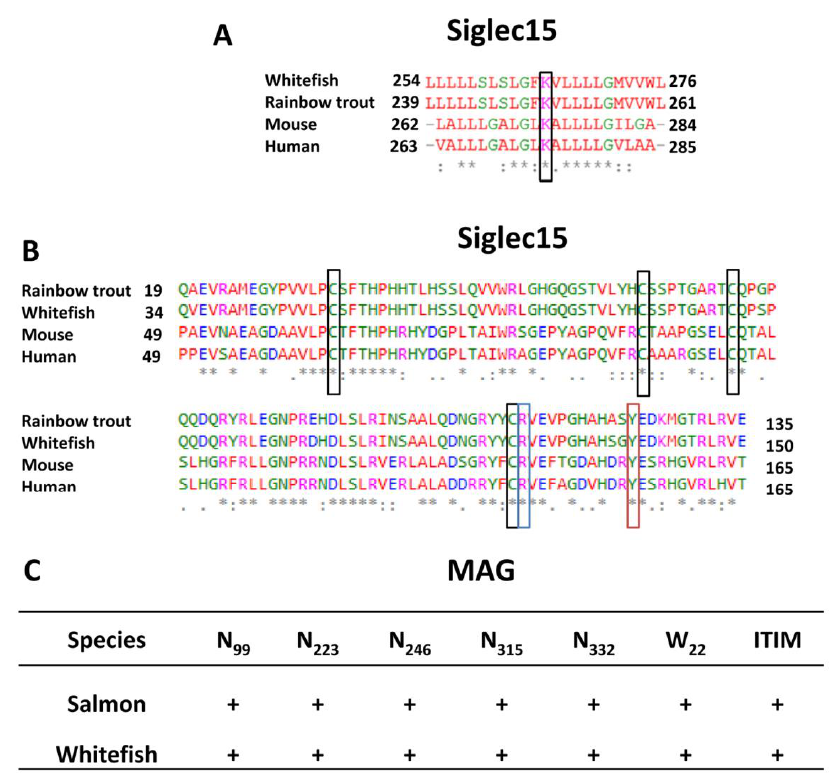
Figure 5. Analysis of specific properties of Siglec15 and MAG. ( A ) Sequence alignment of the transmembrane domain of Siglec15. The positions of the transmembrane domains of murine and human Siglec15 were retrieved from Uniprot, while the transmembrane area of Siglec15 from maraena whitefish and rainbow trout were predicted using SMART. The black box highlights the transmembrane lysine residue, which interacts with DAP10/12. ( B ) Sequence alignments of the first Ig domain of Siglec15. The alignment illustrates the conserved cysteine residues (black boxes) of Siglec15 as well as the conserved arginine residue (blue box) and a conserved hydrophobic amino acid (Y, red box), which are involved in sialic acid-binding [17]. Sequence alignments were performed using the Clustal Omega tool of EMBL-EBI. Different colors label the chemical properties of the amino acids: red, small hydrophobic/aromatic amino acids; blue, acidic amino acids; magenta, basic amino acids; green, hydrophilic, polar, and small amino acids. ( C ) The presence of specific N-glycosylation sites and IIM motifs of MAG from salmon and whitefish are shown. The position of the amino acid residue refers to the human sequence. For accession numbers, see Subsection 2.7.